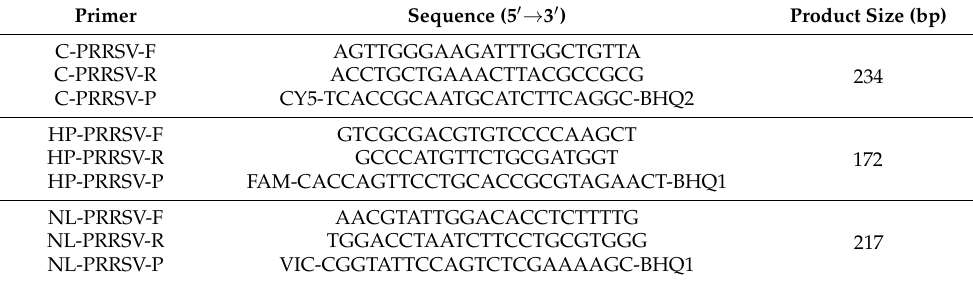
Table 1. Primers and probes for detection of C-PRRSV, HP-PRRSV, and